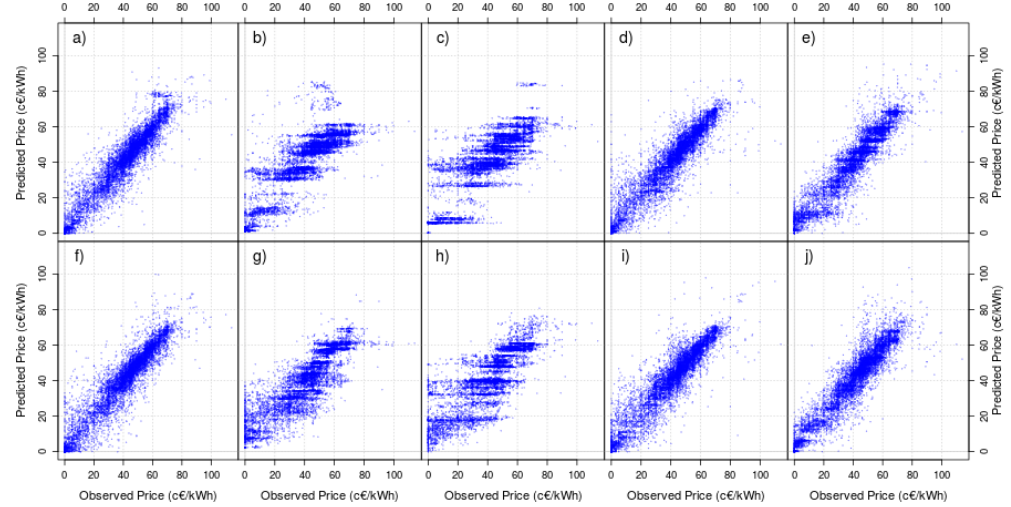
Figure 4. Plots of observed ( x ) versus one-hour ahead predicted ( y ) prices for DT with constant mean and a moving window of ( a – e ) 10 days and ( f – j ) 50 days. ( a , f ) Full model, ( b , g ) retire the oldest data, ( c , h ) retire the data discarded by active learning, ( d , i ) retire the oldest data and rejuvenate the particle set and ( e , j ) retire the data discarded by active learning and rejuvenate the particle set.